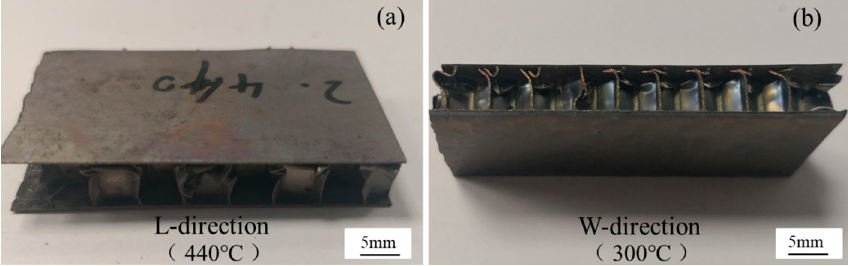
Figure 9. Typical load-deflection curves of the L-direction and W-direction sandwich panels at ( a ) 20 °C, ( b ) 160 °C, ( c ) 300 °C and ( d ) 440 °C. The load–deflection curves of the L-direction and W-direction sandwich panels generally show a bilinear behavior at 20 °C. There is a sudden load drop when the load reaches the maximum, which indicates that a brittle failure has occurred for each type of sandwich panel. It can also be observed that the maximum load of the L-direction panel is larger than that of the W-direction panel, while the deflection of the L-direction panel is smaller than that of the W-direction panel. The horizontal segment of the load-deflection curves reveals the appearance of plastic deformation for both types of sandwich panels at 160 °C. The load also has a sudden drop when reaching the maximum, which indicates the occurrence of a brittle fracture behavior as well. The maximum load and the deflection of the L-direction sandwich panel both are larger than those of the W-direction sandwich panel. For each type of sandwich panel at 160 °C, the deflection only has about 10% increment relative to the experimental results recorded at 20 °C, while the maximum load of the L-direction and W-direction sandwich panels shows a decrease of 18.4% and 21.2%, respectively. The sandwich panels show a brittle failure at 300 °C. Compared to the load-deflection of the L- direction sandwich panel, an obvious horizontal segment is recorded for the W-direction sandwich